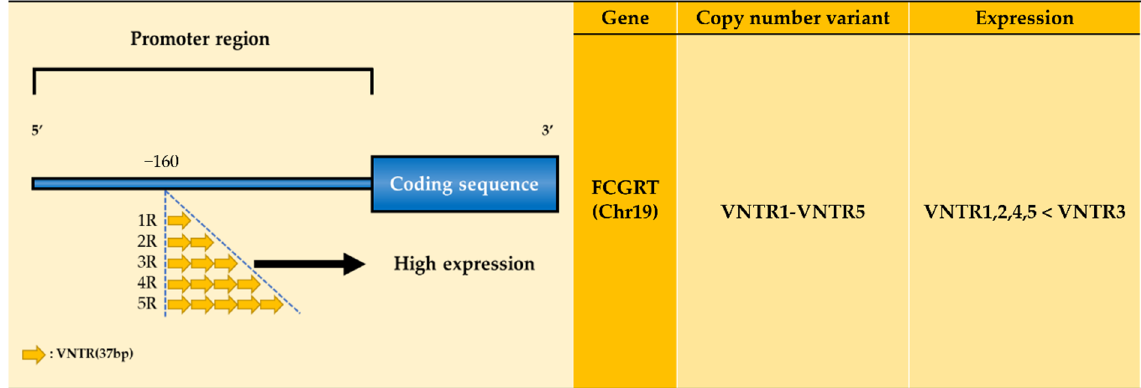
Figure 4. Repeat 3 of VNTR in the promoter of the FCGRT gene shows the highest FcRn